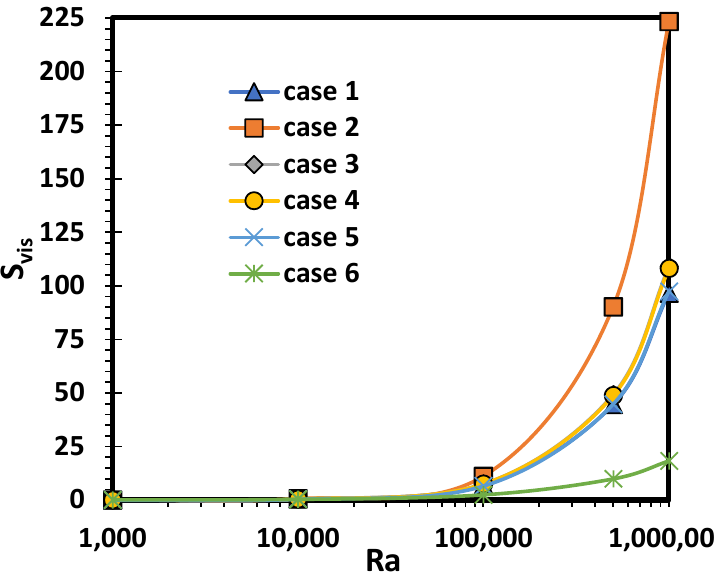
Figure 14. Viscous entropy generation for various heat source positions and different Ra.